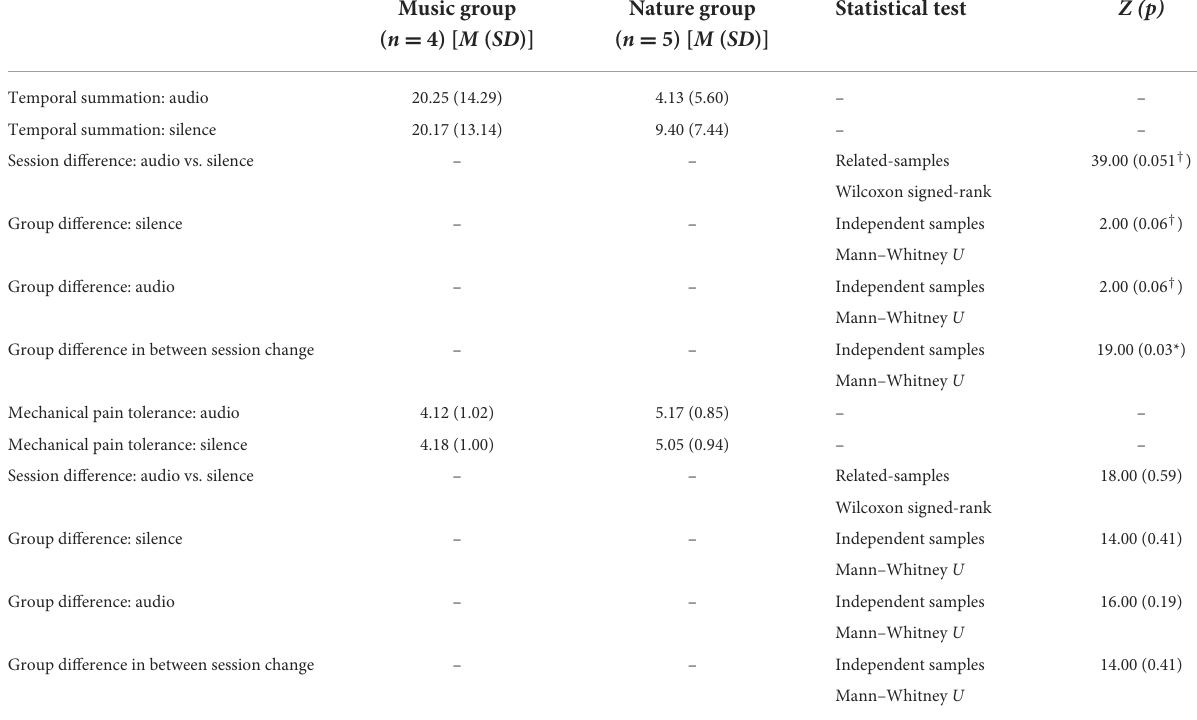
TABLE 3 Pain variables by session (Audio, Silence) and audio group assignment (Music,